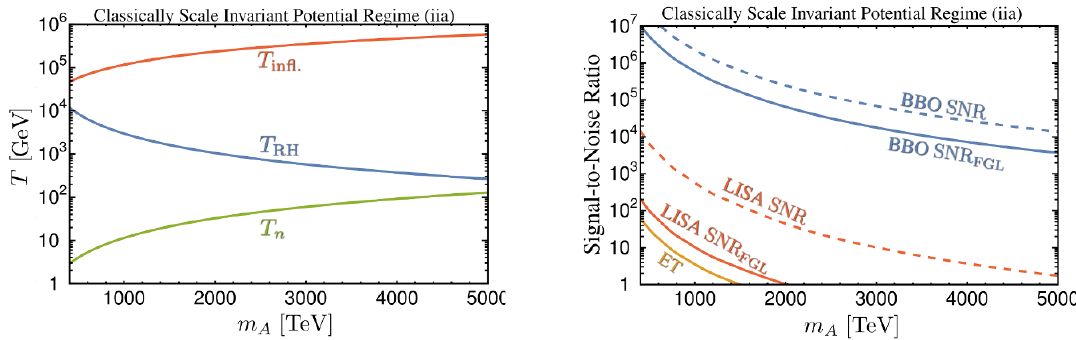
Figure 9 . Left: the temperature when in(cid:13)ation starts, T in(cid:13) , the reheating temperature, T RH , and the nucleation temperature, T n , in regime (iia). The ratio ( T in(cid:13) =T RH ) determines the amount of additional redshifting of the signal due to the matter dominated reheating period following the PT. Right: the detectability of the GW signal in regime (iia). Here the BM criterion holds over the entire range.